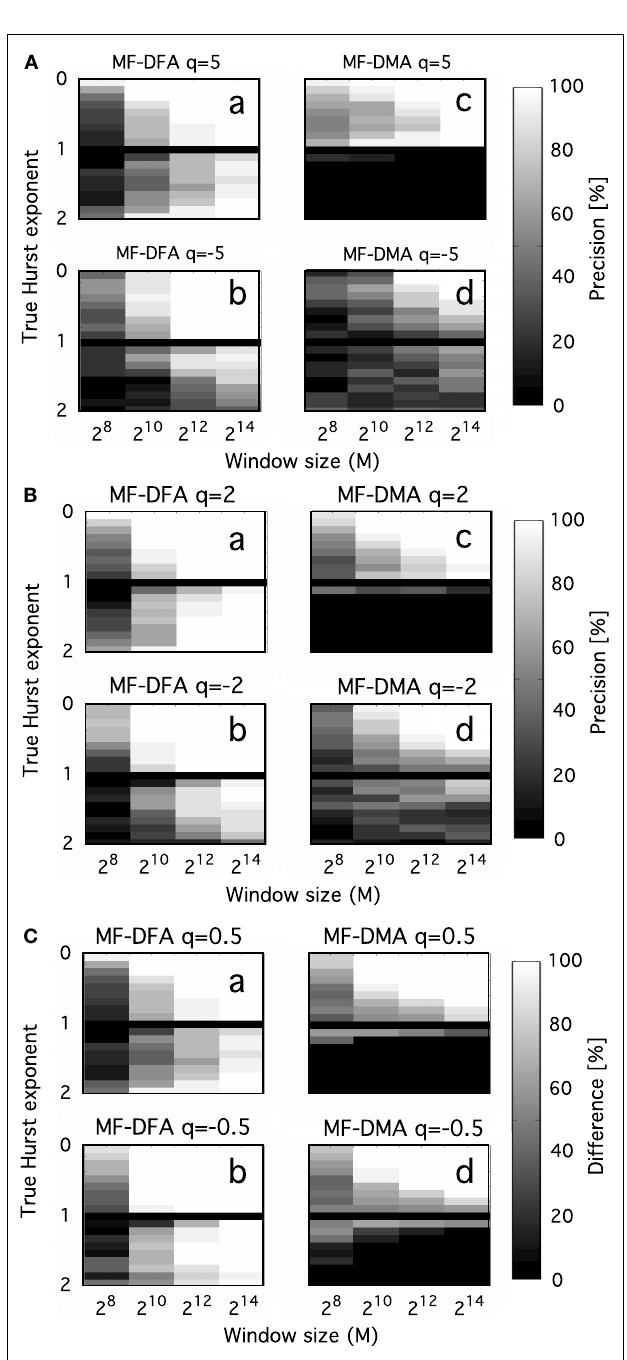
FIGURE 6 | Precision as a function of moment order, signal length, and Hurst exponent. Precision of MF-DFA [left side of (A–C) ] and MF-DMA [right side of (A–C) ] as a function of q , H true , N . fGn and fBm signals were generated by DHM with length of 2 8 , 2 10 , 2 12 , 2 14 , and H true increased from 0.1 to 1.9 in steps of 0.1, skipping H true = 1 (corresponding to 1/ f boundary seen as the black horizontal line in the middle). Estimation of the generalized Hurst exponent should not depend on q , as monofractal’s H ( q ) is a theoretically constant function scattering around H true across different order of moments.The intensity-coded precision index is proportional to the number of estimates of H falling into the range of H true ± 0.1, with lighter